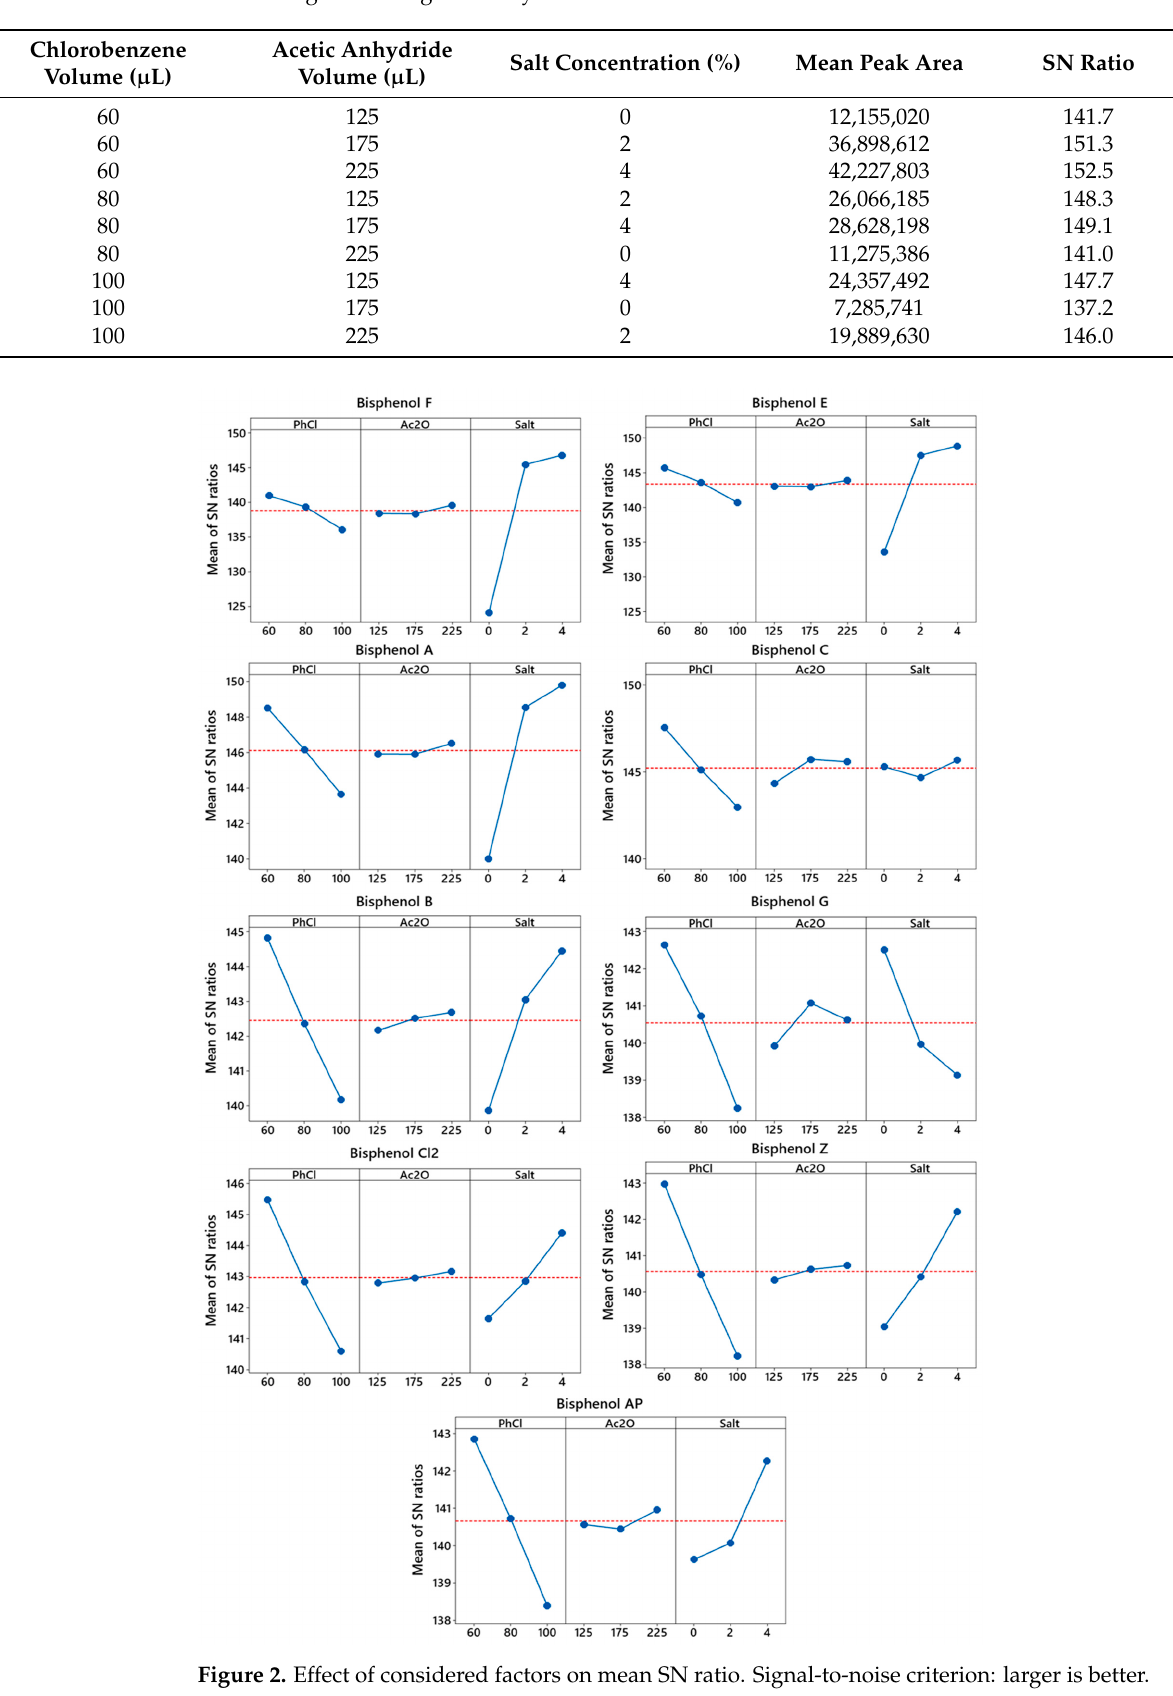
Figure 2. Effect of considered factors on mean SN ratio. Signal-to-noise criterion: larger is better.